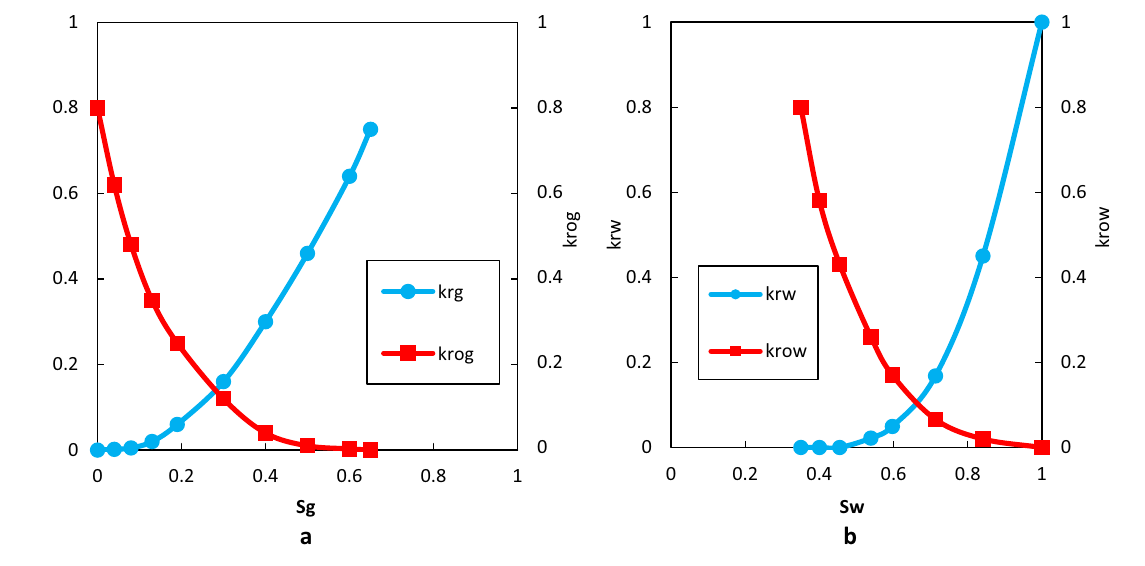
Fig. 2 Matrix relative permeability curves a gas/oil system, b water/oil system